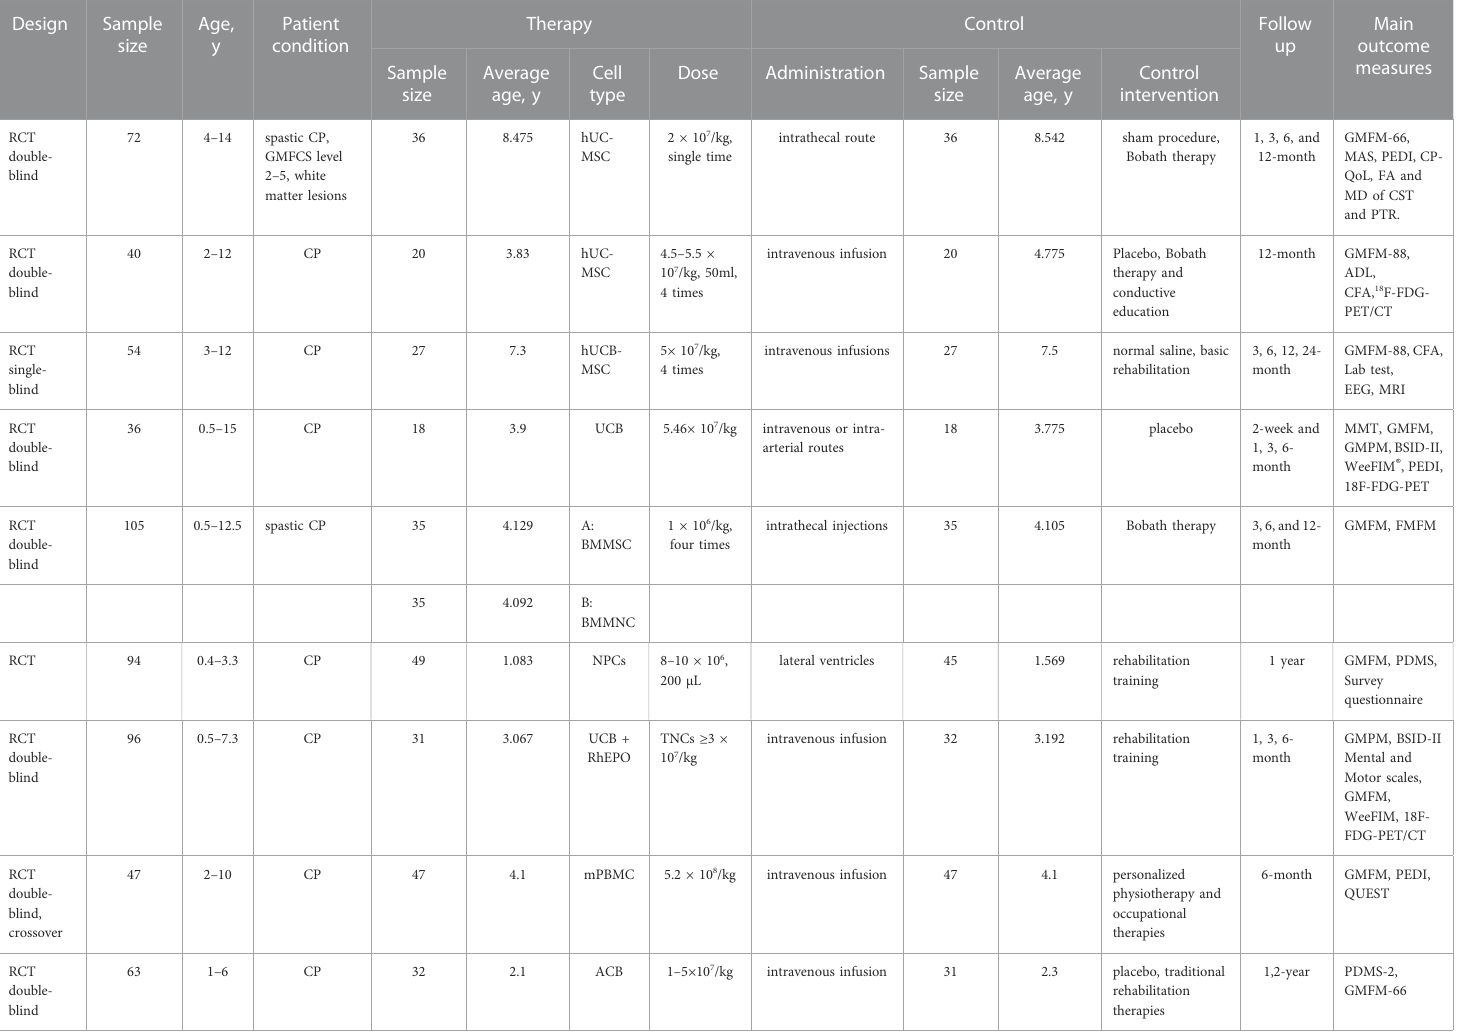
TABLE 1 Summary of Clinical Studies of Stem Cells Therapy for cerebral